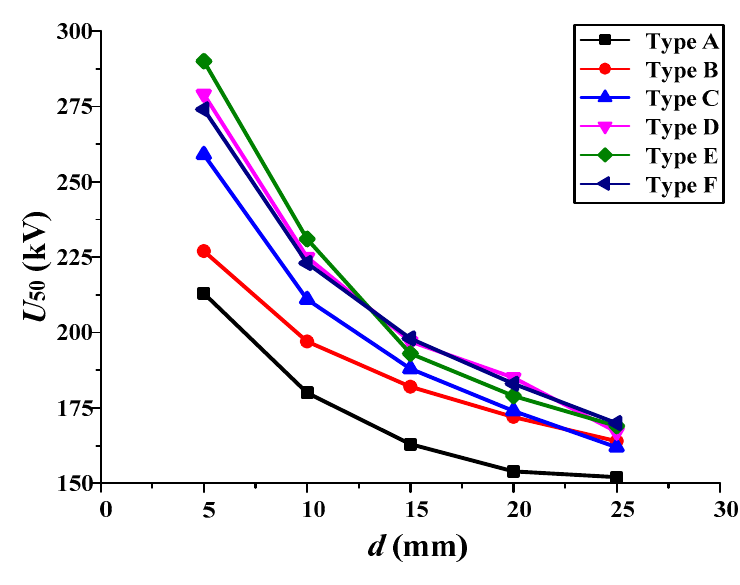
Figure 6. Relationship between U 50 and d . Table 4. The values of A d and c for different types of insulators.